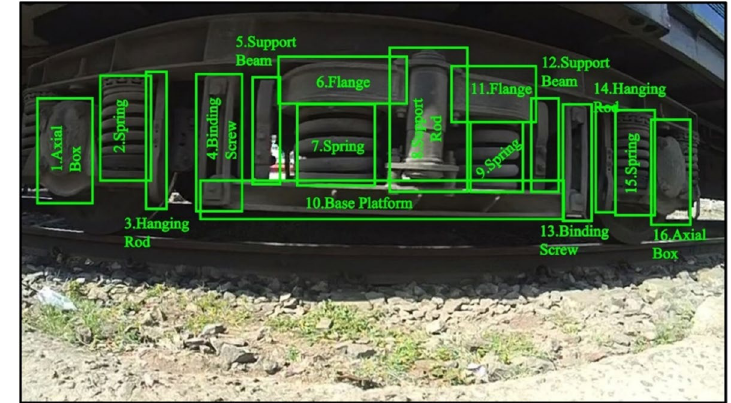
Fig. 7 Bogie parts being identified through the proposed